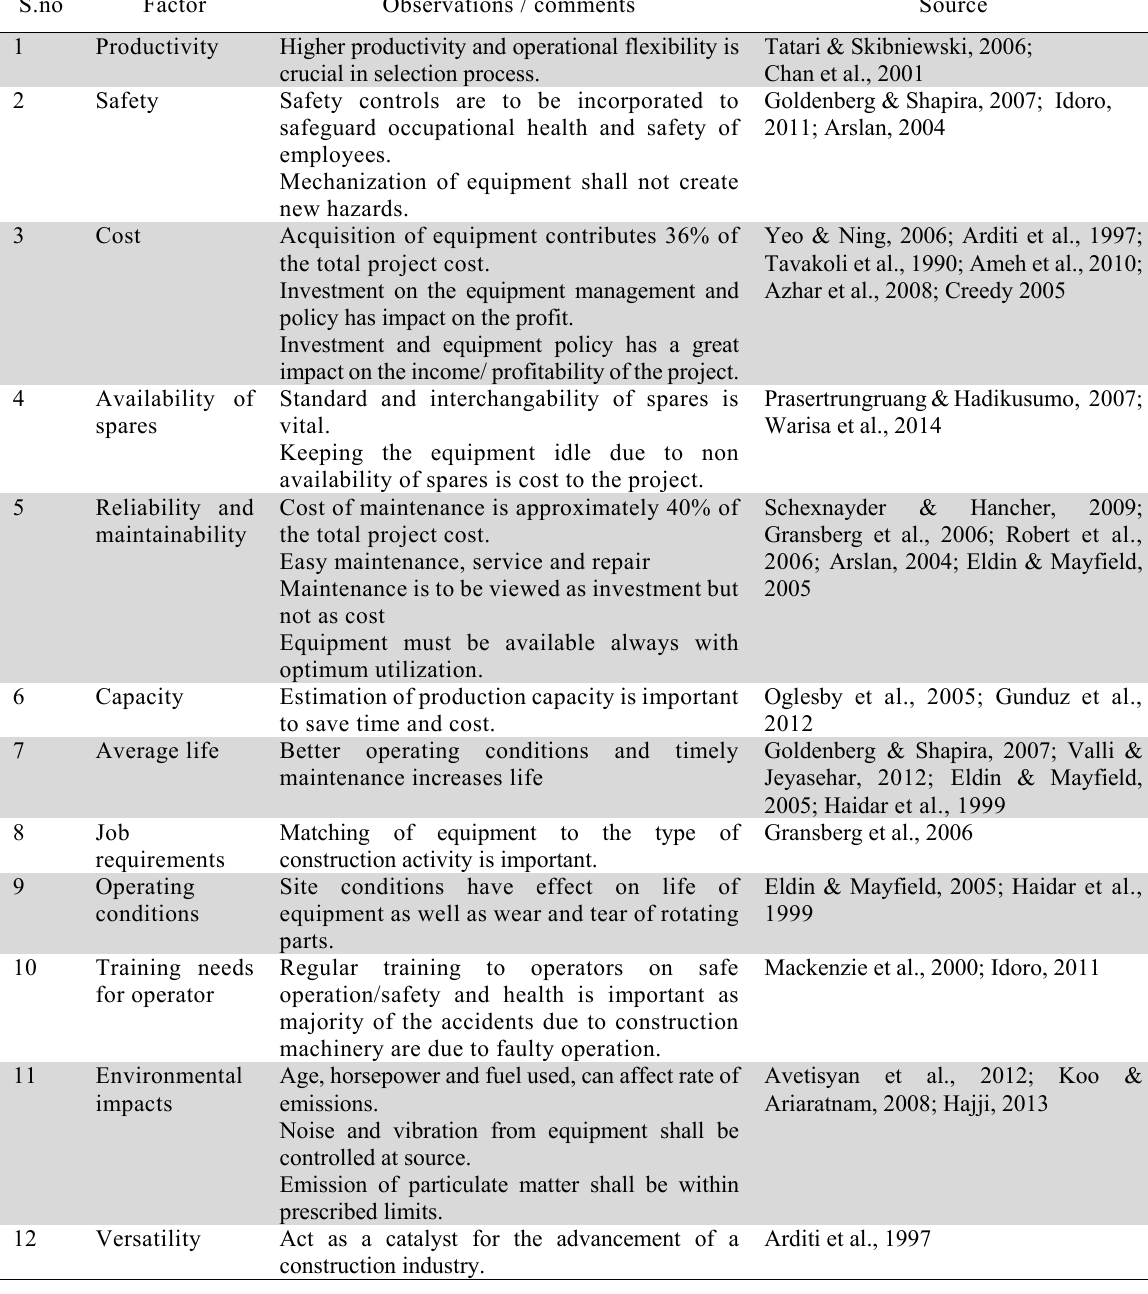
Factors influencing selection of construction